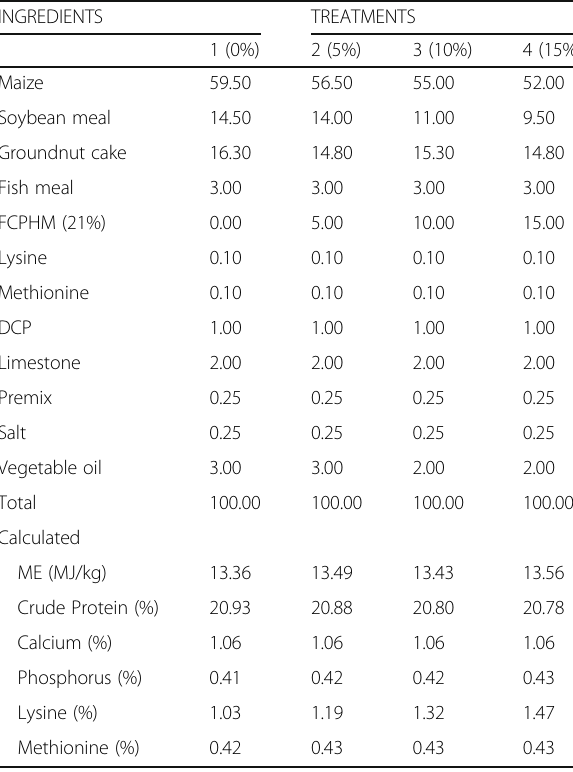
Table 1 Gross composition of the experimental starter diets INGREDIENTS TREATMENTS